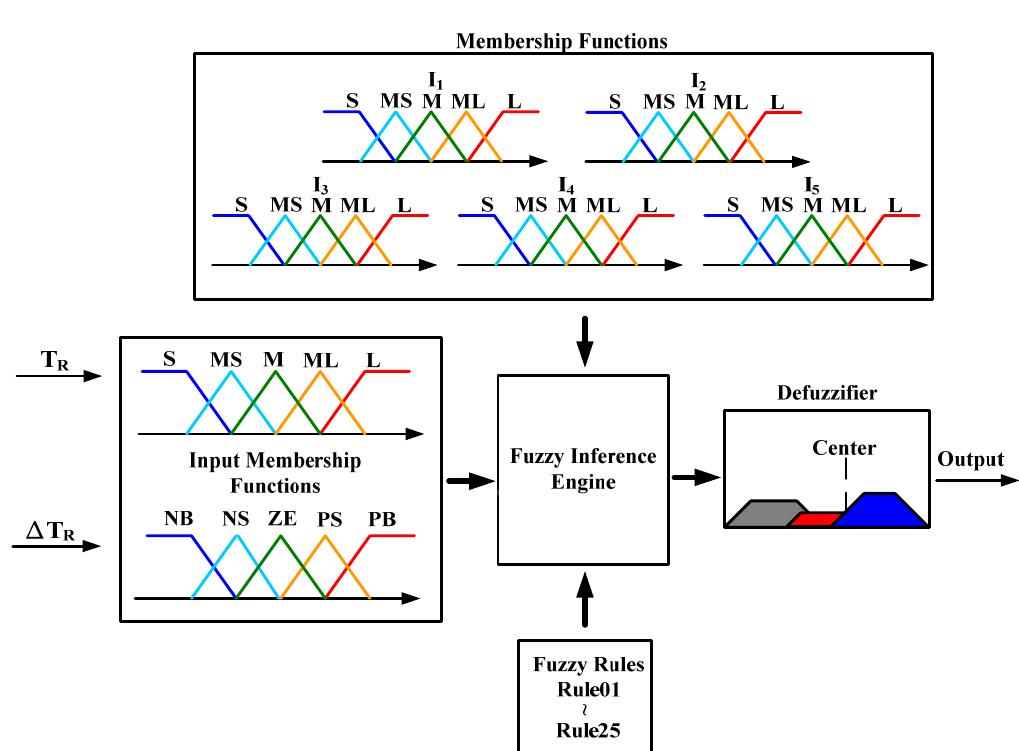
Figure 2. Block diagram of the proposed